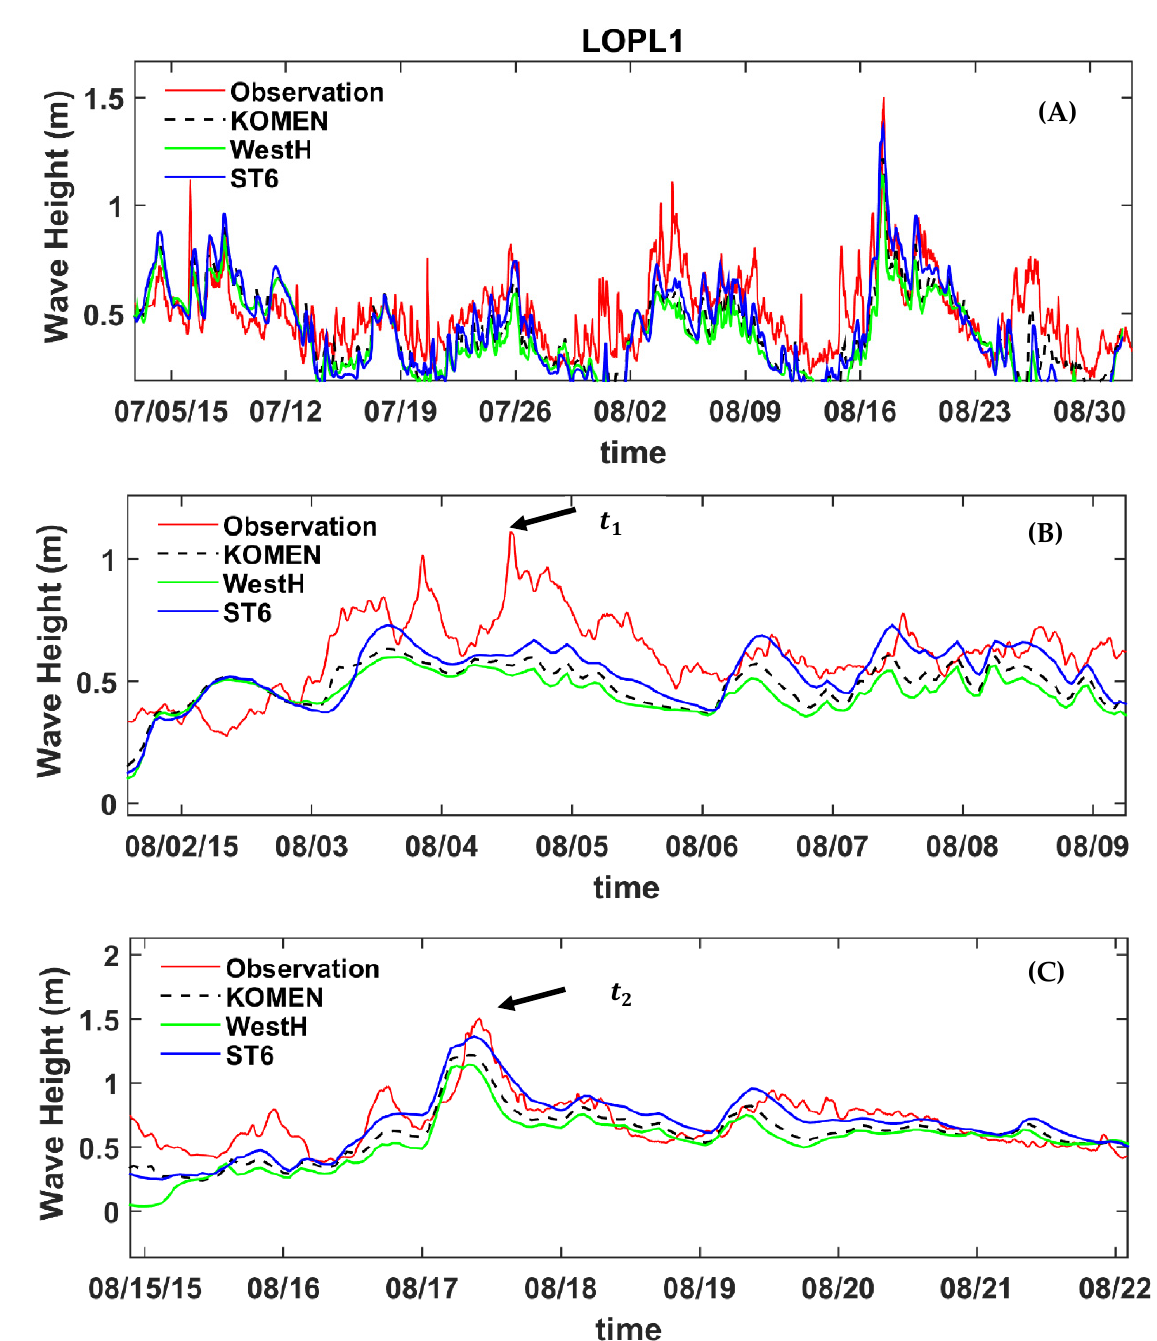
Figure 6. ( A ). Comparison of simulated wave height using different whitecapping formulations with observations at LOPI1 between July and August 2015, ( B ) detailed comparison focusing on time t 1 , ( C ) detailed comparison focusing on time t 2